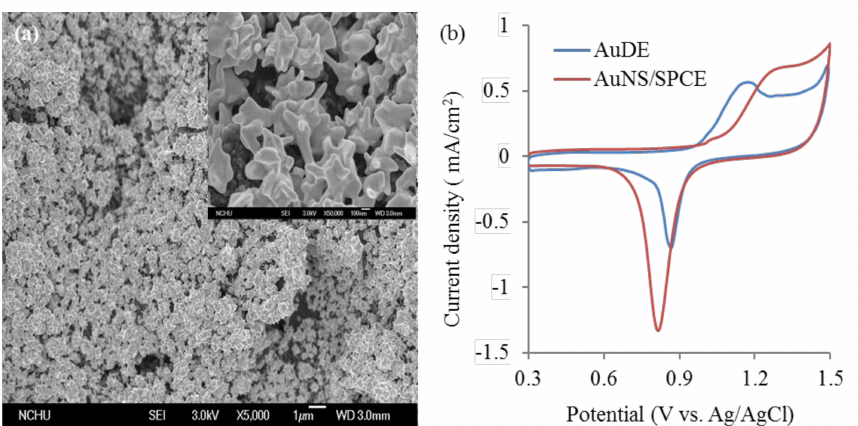
Figure 1. ( a ) SEM images of screen-printed carbon electrodes (SPCEs) after performing two-step gold electrodeposition. The inset shows a high magnification ( × 50000) SEM image. ( b ) Cyclic voltammograms measured at a gold disk electrode (AuDE) of 1.6 mm diameter and a gold nanostructure (AuNS) / SPCE in 50 mM HClO 4 solution with a scan rate of 50 mV / s to calculate the formation and desorption of gold oxide.